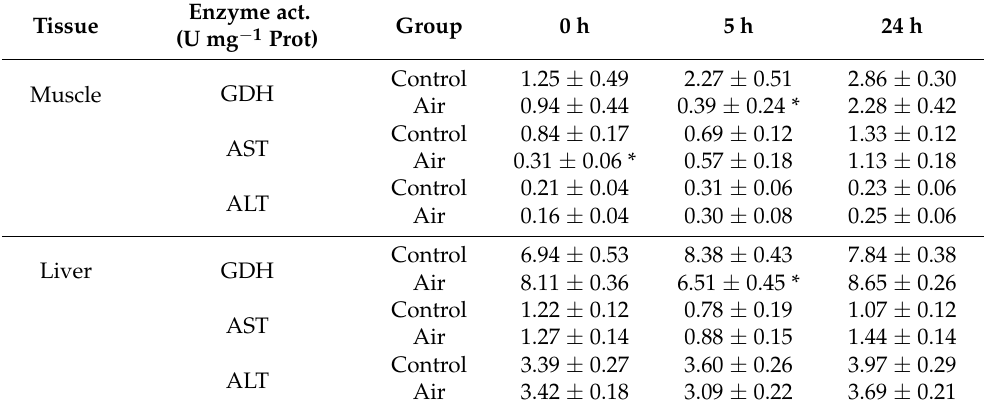
Table 1. Activity of enzymes involved in the intermediary metabolism after air exposure in white muscle and liver of S. canicula . Changes in amino acid turnover-related enzymes activities (glutamate dehydrogenase, GDH; aspartate aminotransferase, AST; and alanine aminotransferase, ALT) activities (in U mg − 1 prot) in white muscle and liver of S. canicula after air exposure. Data are expressed as mean ± s.e.m. Asterisks (*) indicate significant differences between both groups at each sampling time ( p < 0.05, n = 7–8). Enzyme act. Group 0 h Tissue (U mg − 1 Prot)